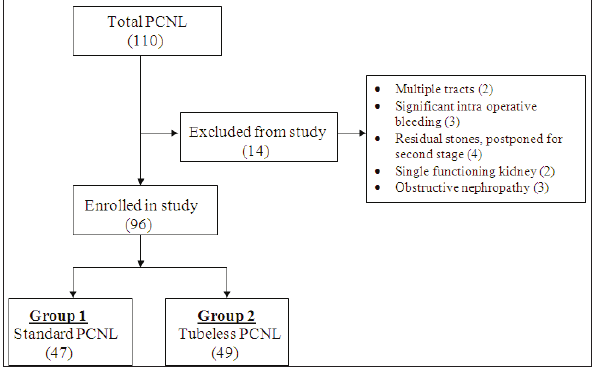
Figure 1: Consort diagram of the study Patients were evaluated thoroughly with a complete history, physical examination, urinalysis, urine culture and sensitivity test, renal function test, ultrasonography of kidneys, ureter and bladder (KUB) and intravenous urography (IVU) or CT urography. A prophylactic antibiotic (Ceftriaxone 1gm) was administered in all cases before induction of general anesthesia. All PCNLs were performed by the same team of surgeons according to a standard